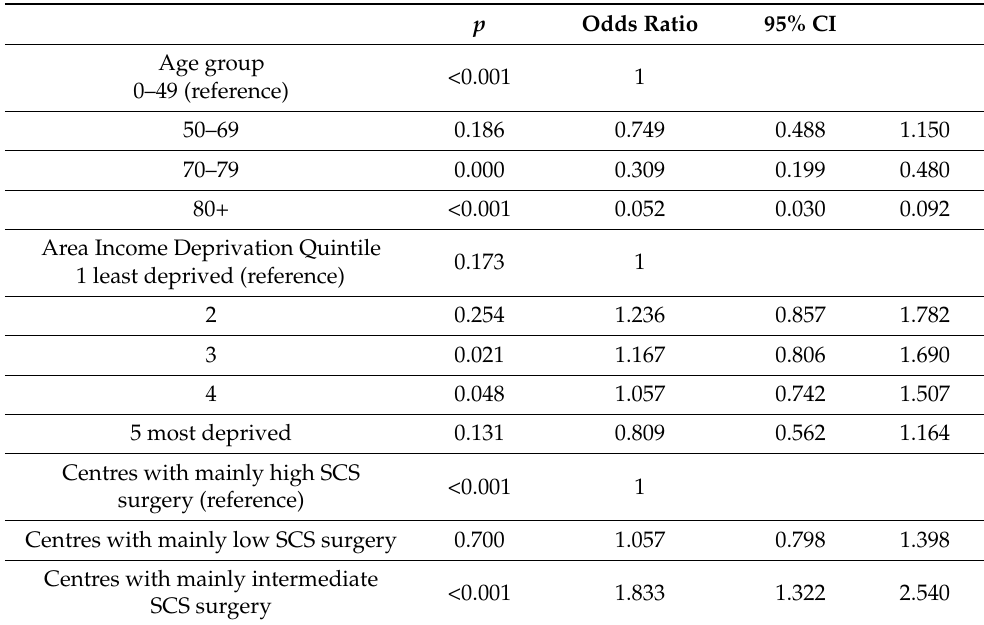
Adjusted Odds Ratios (logistic regression) for undergoing both surgical resection and